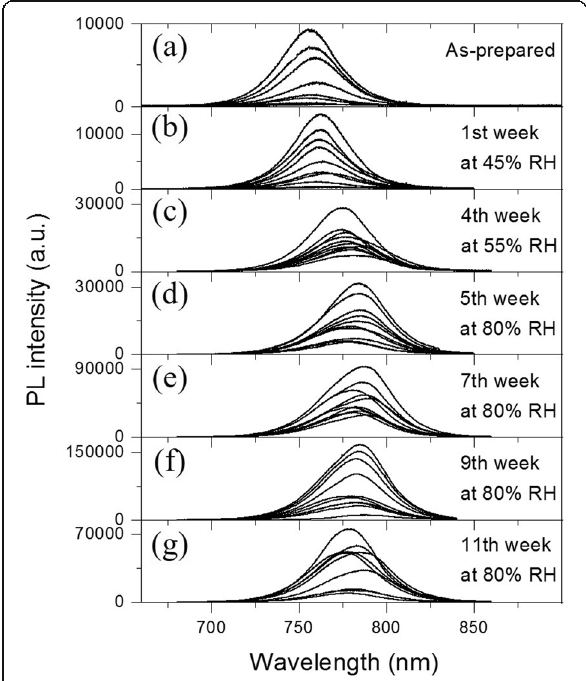
Fig. 2 Photoluminescence spectra of MAPbI 3 MWs at different stages of humidity exposure. a As-prepared sample, after the b 1st week at 45% RH, c 4th week at 55% RH, and d 5th, e 7th, f 9th, and g 11th weeks at 80% RH. All spectra taken in ambient conditions, with an excitation wavelength of 633 nm, a laser power ~5 μ W, an acquisition time of 10 s, and a laser spot diameter of ~1 μ m on the